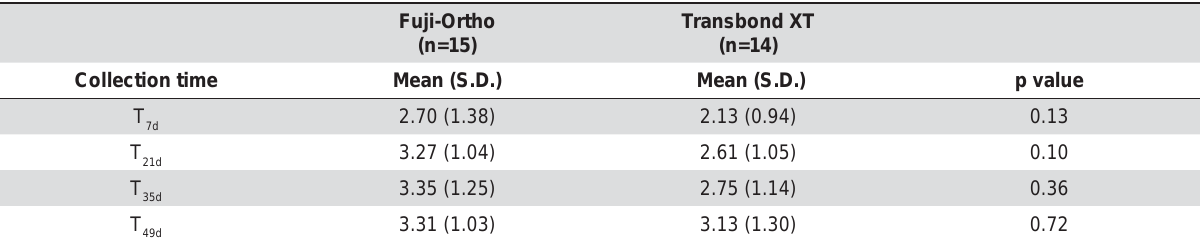
Table 2- Means of Streptococcus mutans (cid:3)(cid:62)(cid:79)(cid:82)(cid:74)(cid:11)(cid:70)(cid:73)(cid:88)(cid:12)(cid:18)(cid:80)(cid:47)(cid:64)(cid:3)(cid:76)(cid:81)(cid:3)(cid:71)(cid:72)(cid:81)(cid:87)(cid:68)(cid:79)(cid:3)(cid:69)(cid:76)(cid:82)(cid:191)(cid:79)(cid:80)(cid:3)(cid:68)(cid:71)(cid:77)(cid:68)(cid:70)(cid:72)(cid:81)(cid:87)(cid:3)(cid:87)(cid:82)(cid:3)(cid:87)(cid:75)(cid:72)(cid:3)(cid:69)(cid:85)(cid:68)(cid:70)(cid:78)(cid:72)(cid:87)(cid:86)(cid:3)(cid:68)(cid:70)(cid:70)(cid:82)(cid:85)(cid:71)(cid:76)(cid:81)(cid:74)(cid:3)(cid:87)(cid:82)(cid:3)(cid:87)(cid:75)(cid:72)(cid:3)(cid:82)(cid:85)(cid:87)(cid:75)(cid:82)(cid:71)(cid:82)(cid:81)(cid:87)(cid:76)(cid:70)(cid:3)(cid:69)(cid:82)(cid:81)(cid:71)(cid:76)(cid:81)(cid:74)(cid:3) material and sample collection